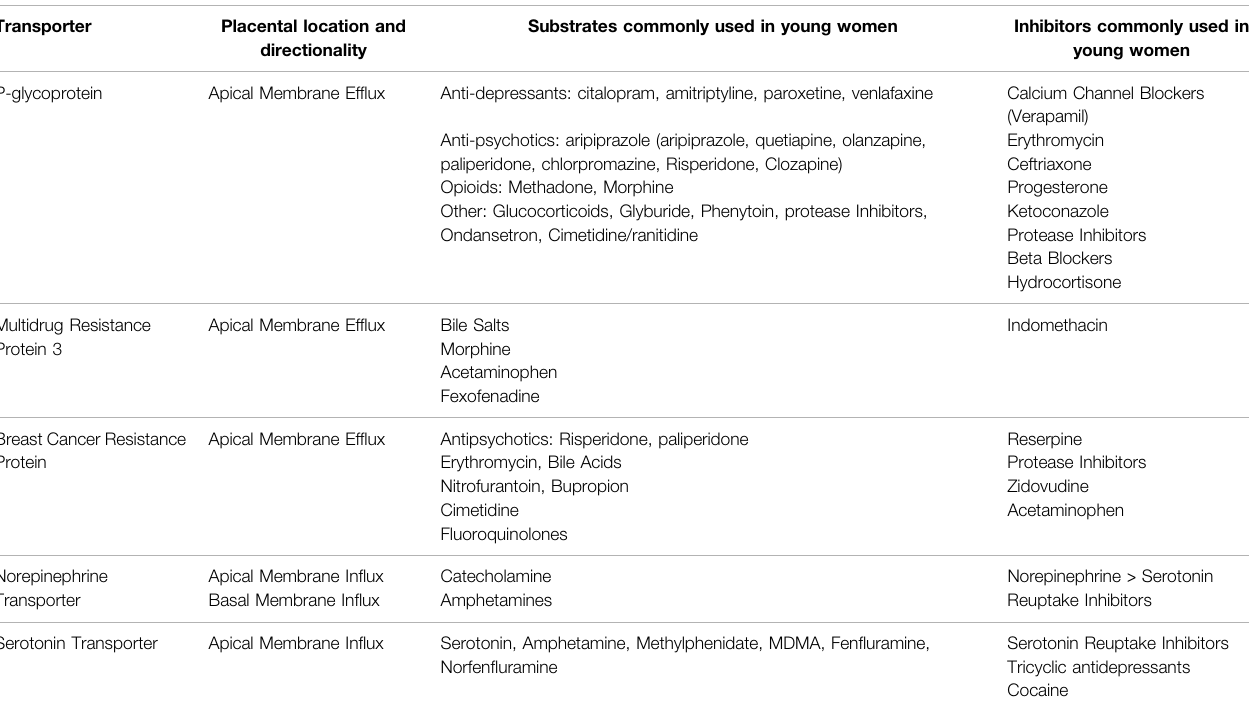
TABLE 1 | Placental transporters and their clinical relevance in pregnancy.